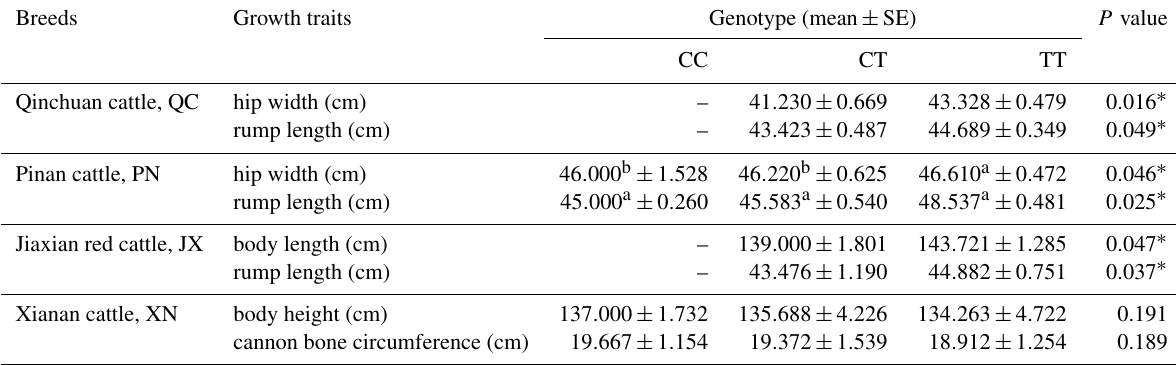
Table 3. Association analysis of SNP with growth traits in four cattle populations. Breeds